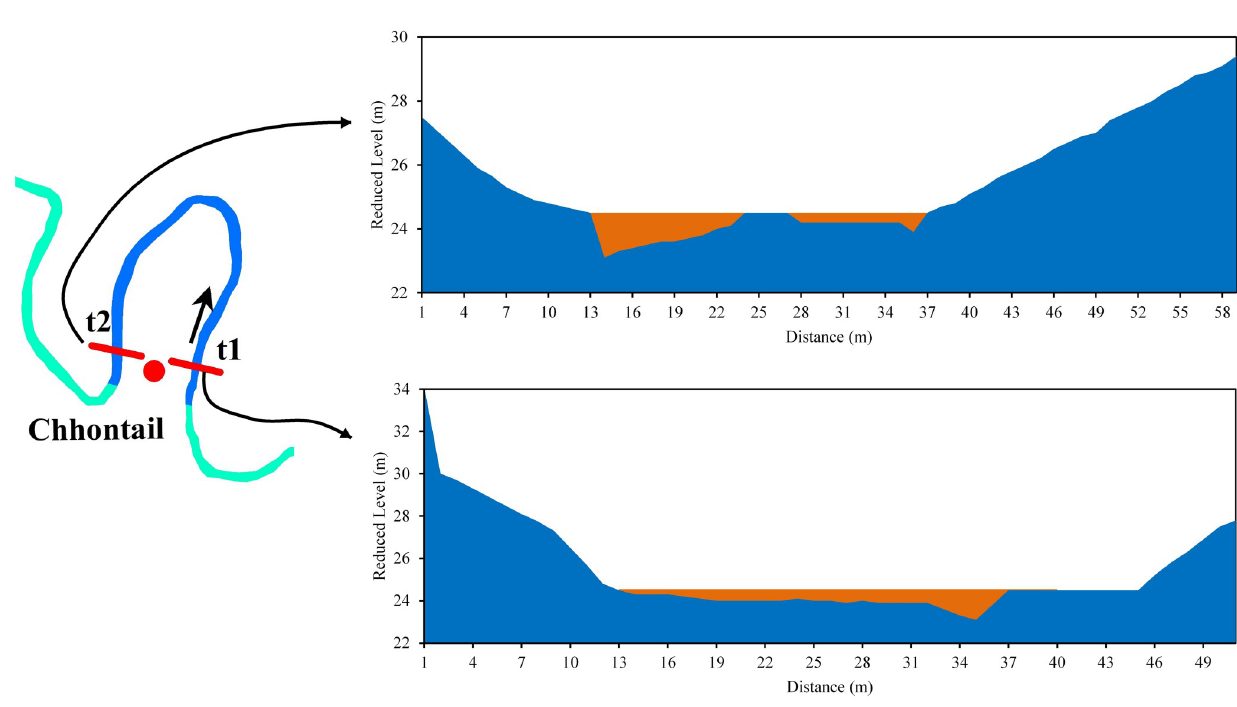
Fig 13. Cross-section across the Manu River at Chhontail (a) t1 (b) t2.